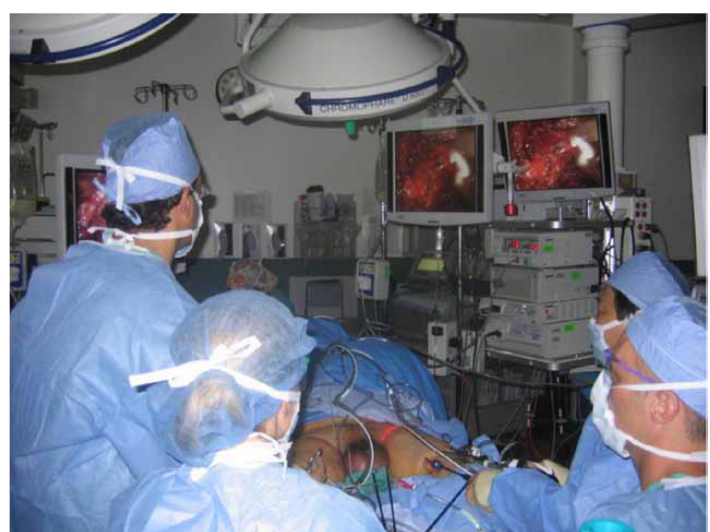
Figure 1 - Simultaneous bilateral